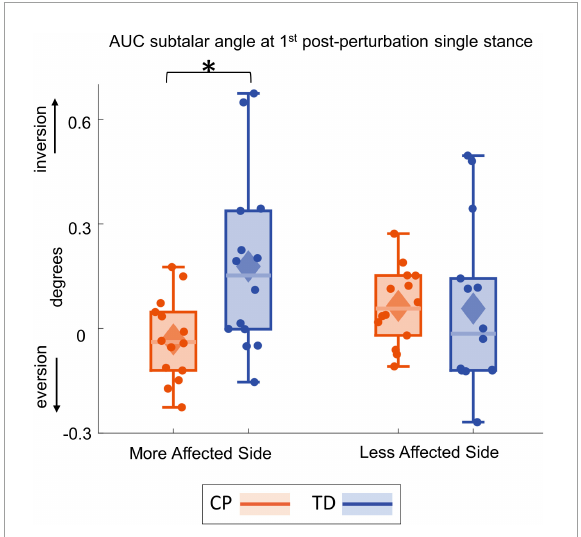
FIGURE5 Box and whisker plots, with scattered dots indicating each subject, for AUC (cid:49) subtalar angle for CP (orange) and TD (blue) groups on the more affected (left) and less affected (right) side. Asterisk indicates p < 0.05 for post hoc pairwise comparisons.